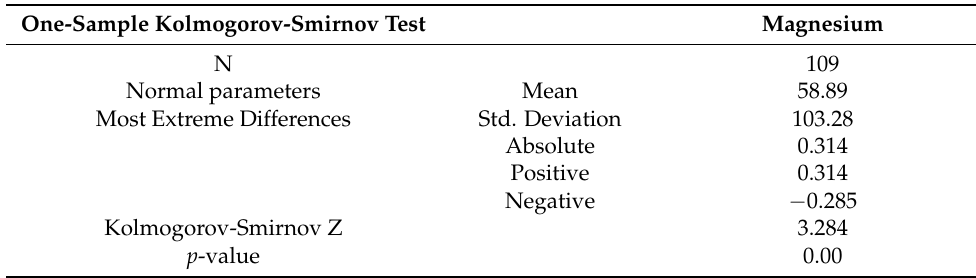
Table 3. Not normal data tabulation before normality testing.